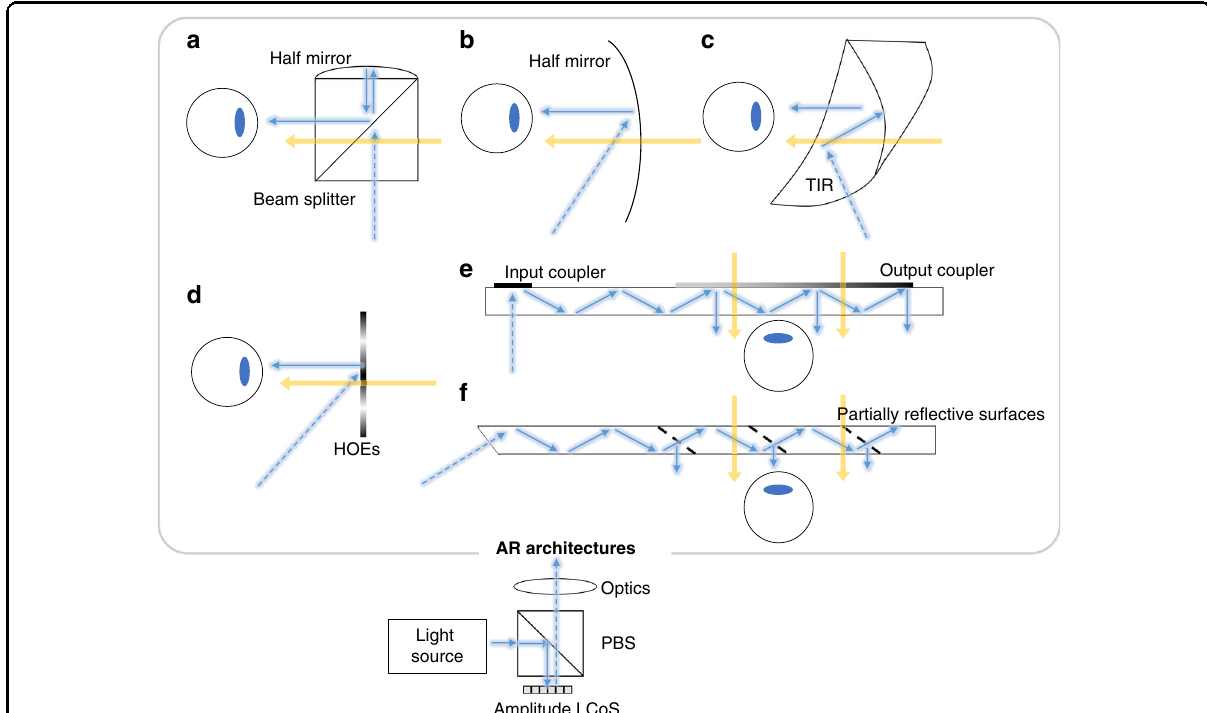
Fig. 6 Amplitude LCoS for different AR architectures. a Birdbath optics with beam splitter. b Single freeform surface as combiner. c Freeform TIR prism as the combiner. d HOEs-based combiner with compact form factor. Waveguide AR with e diffractive couplers and f partially refractive